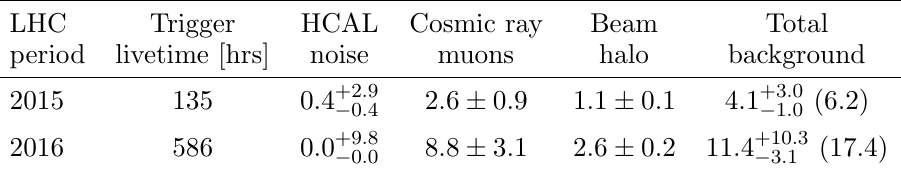
Table 4 . The background prediction for the calorimeter search. The total background median value is listed in parentheses; this value corresponds directly to the median expected limits shown